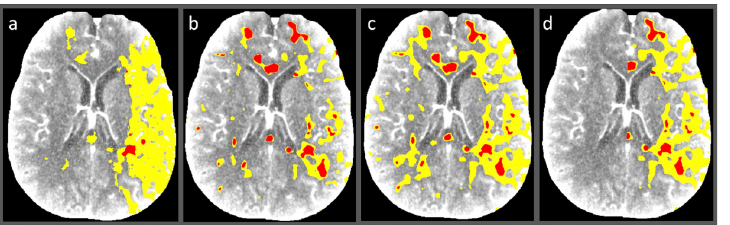
Fig 4. Illustrative computed tomographic perfusion map images for a patient with ischemic stroke. (A–C) Data were postprocessed using the threshold values adapted to Syngo.via from another commercial software package (setting 1) (A), up-to-date company-recommended threshold values for Syngo.via (setting 2) (B), and older Syngo.via default parameters used in a reference study (setting 3) (C). (D) Limiting the analysis to the affected hemisphere